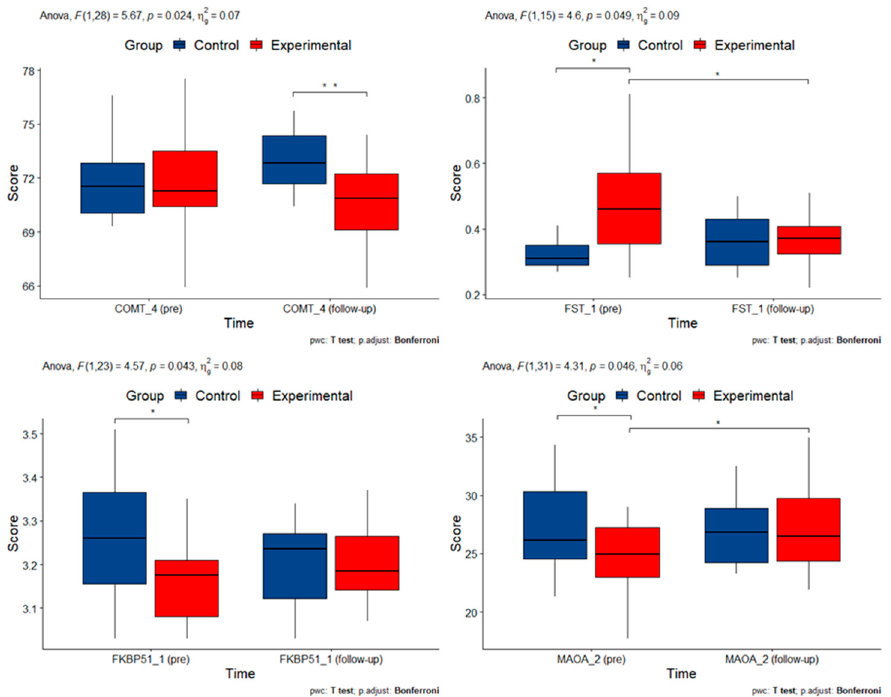
Figure 6. Box plots of measurements of DNA methylation changes with statistically significant interactions. Asterisks denote statistically significant pairwise comparisons.